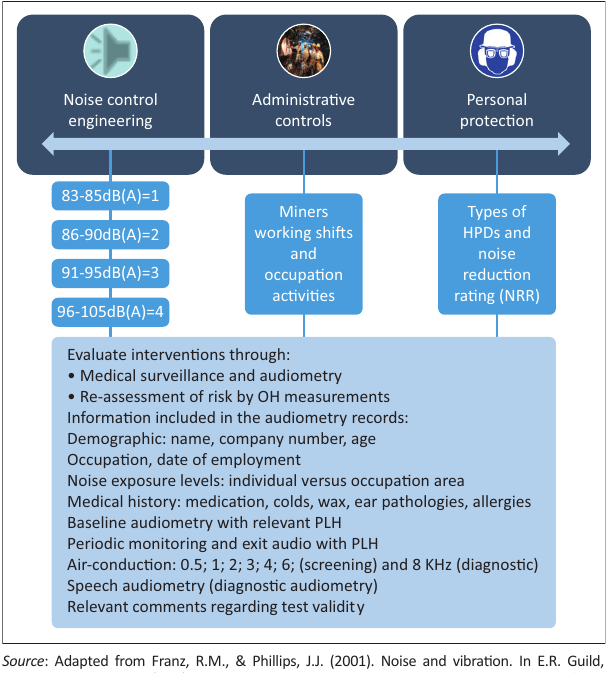
FIGURE 1: Functional structure of a risk management system for occupational